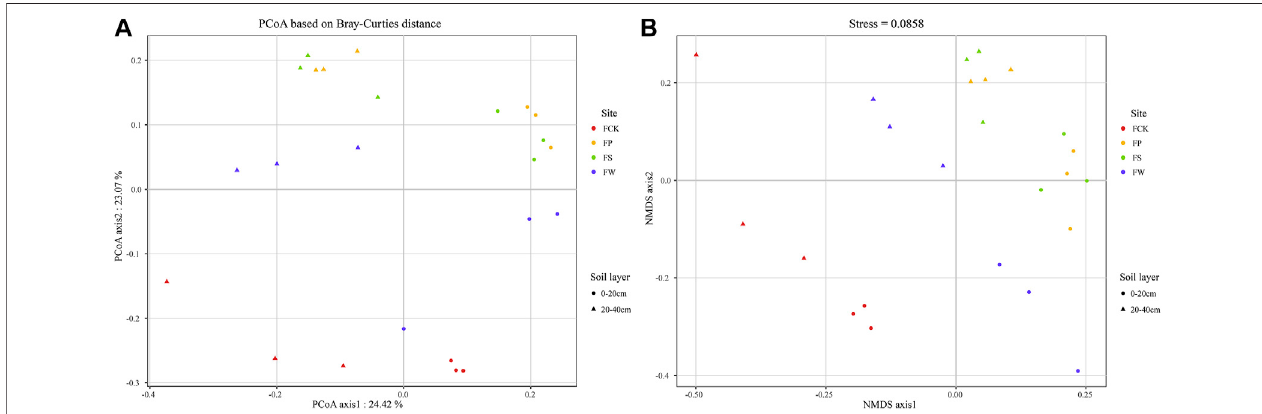
FIGURE 2 | Principal coordinates analysis (PCoA) ordination (A) and non-metric multidimensional scaling (NMDS) ordination (B) based on Bray-Curtis distance at OTU level showing the effects of different vegetation species on bacterial communities among different sites. The circles represent topsoil. The triangles represent subsoil. The colors of the nodes represent different sites. Note: Site abbreviations are de fi ned in Figure 1 .